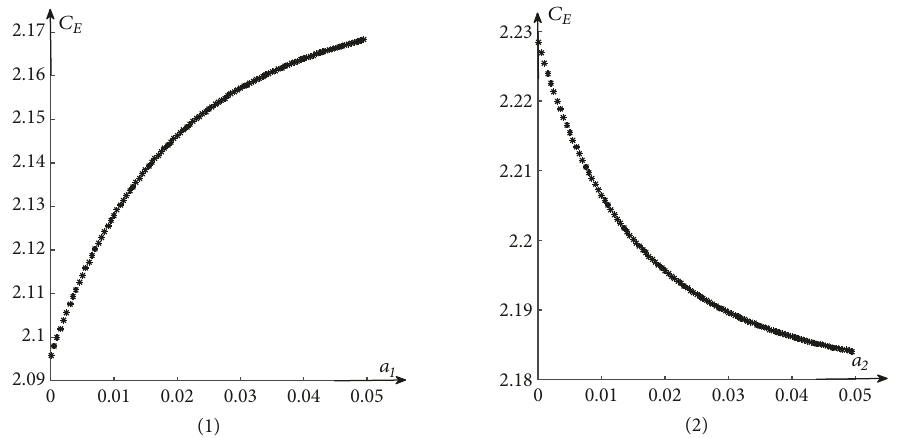
Figure 4: European call currency option price 𝐶 𝐸 versus parameters 𝑎 1 and 𝑎 2 , where (1) 𝐶 𝐸 versus 𝑎 1 ; (2) 𝐶 𝐸 versus 𝑎 2